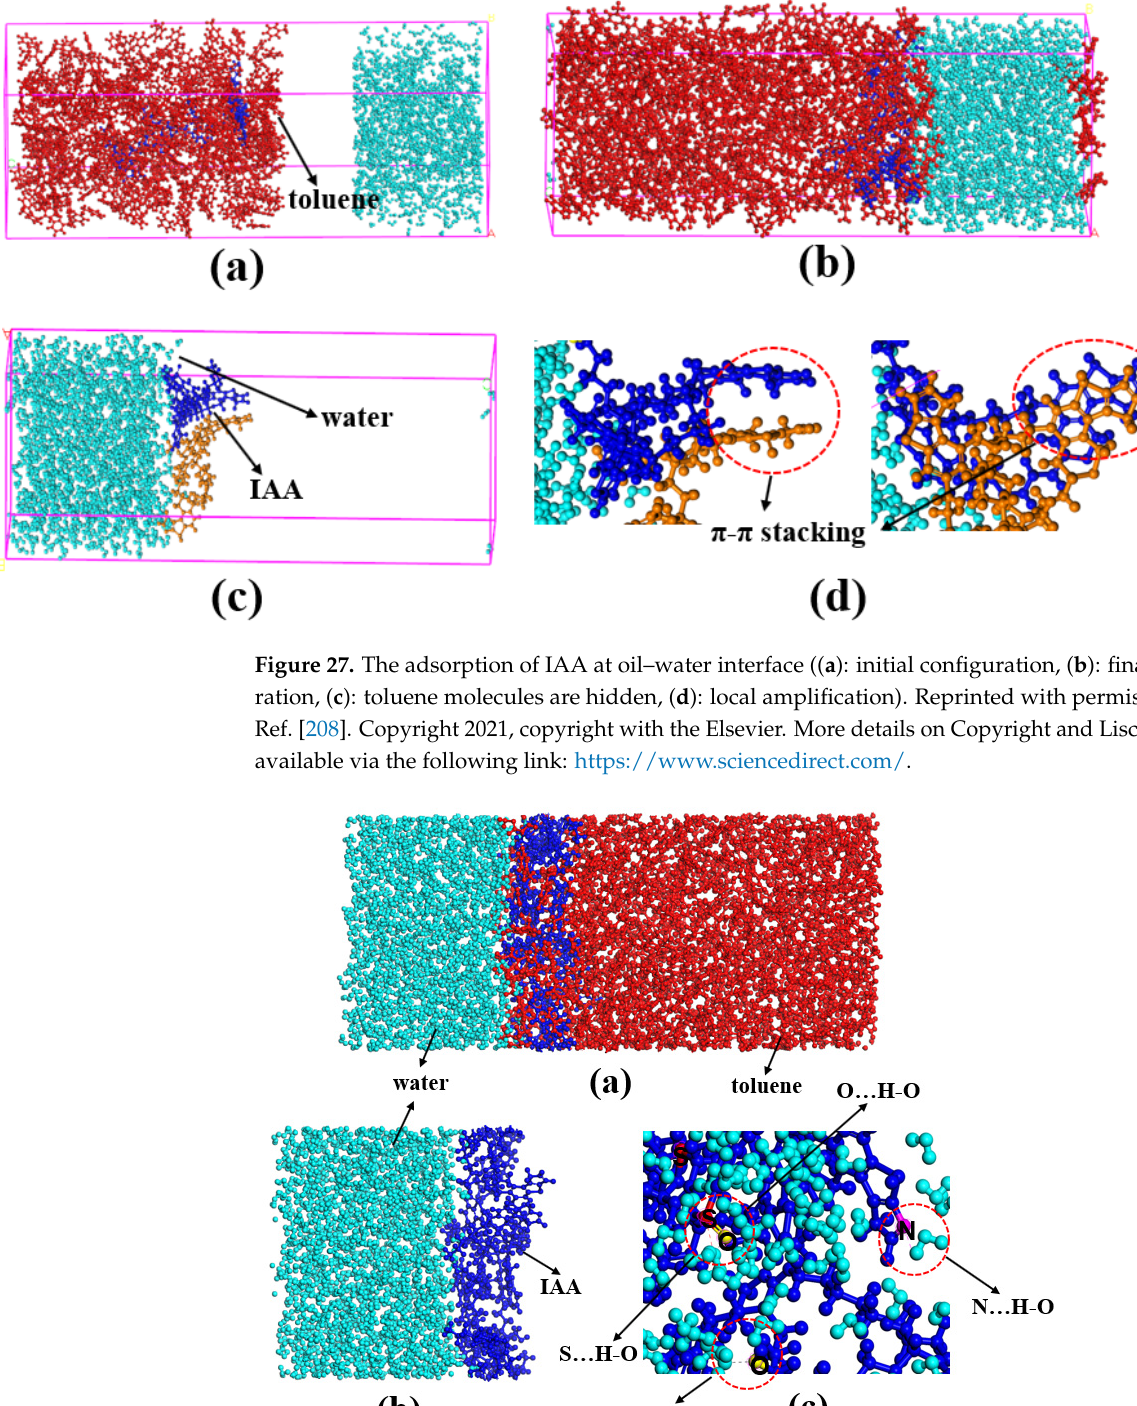
Figure 26. Aggregated system of IAA containing heteroatom (( a ): initial configuration, ( b ): toluene molecules were hidden, ( c ): hydrogen atoms and fat chain were hidden (the blue number represents the hydrogen bond distance, the black number represents the π – π bond distance, unit is Å), ( d ): local amplification). Reprinted with permission from Ref. [208]. Copyright 2021, copyright with the Elsevier. More details on Copyright and Liscensing are available via the following link: https://www.sciencedirect.com/.